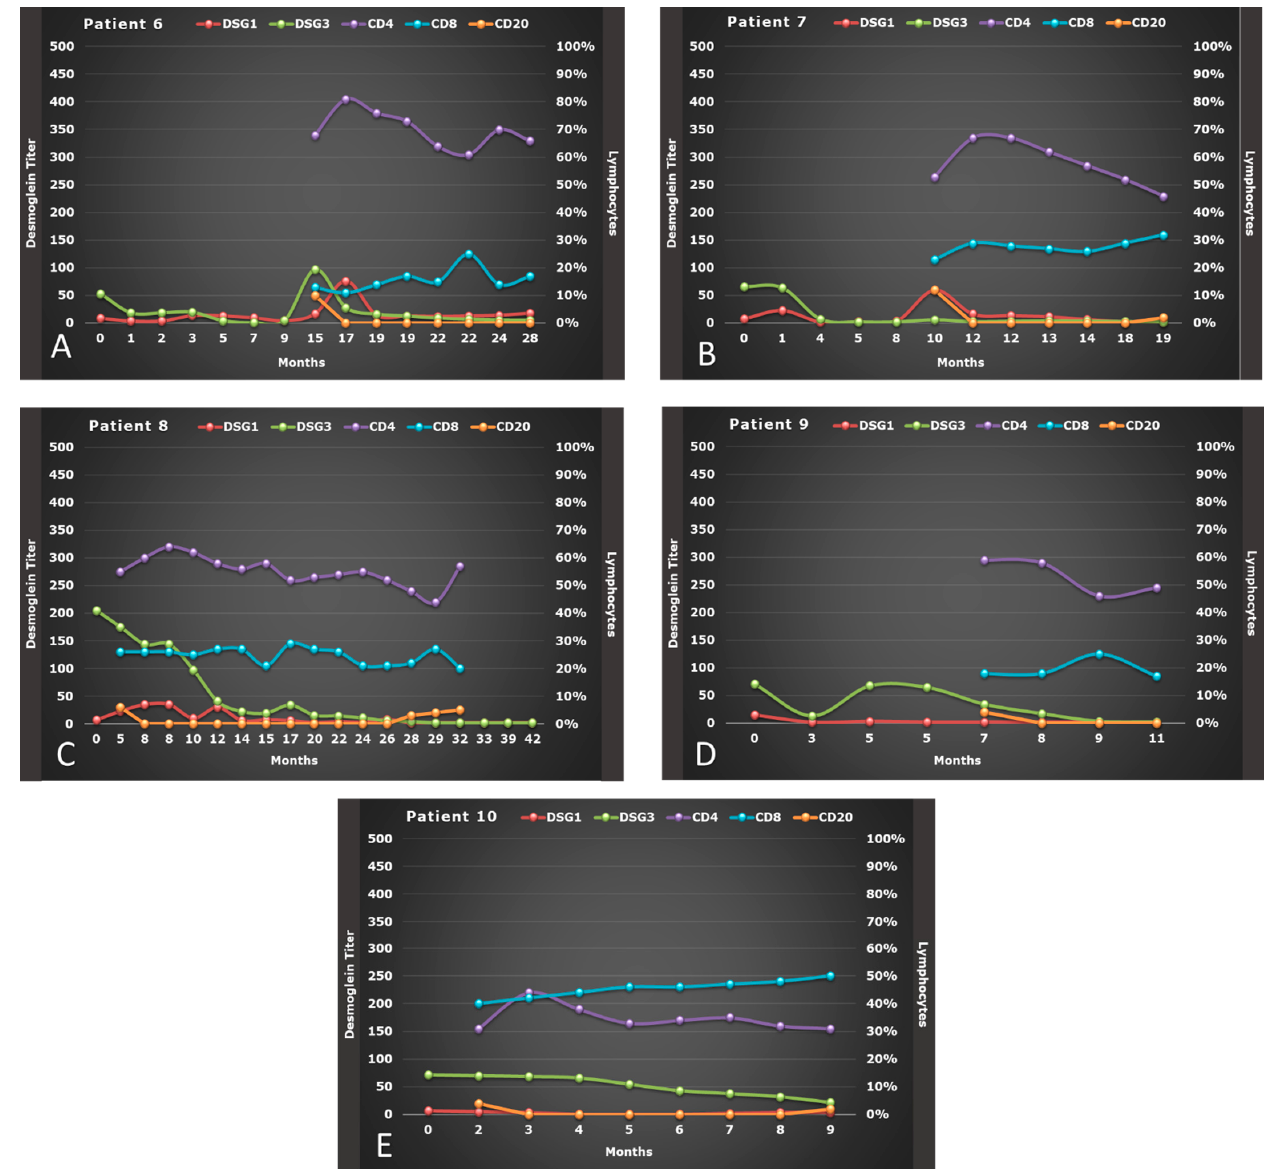
Figure 2. ( A–E ) Evolution of anti-desmoglein (DSG 1 and 3) antibody titer, of CD4, CD8, and CD20, and PDAI-oral mucosa of OPV patients (#6–10) during therapy with RTX.